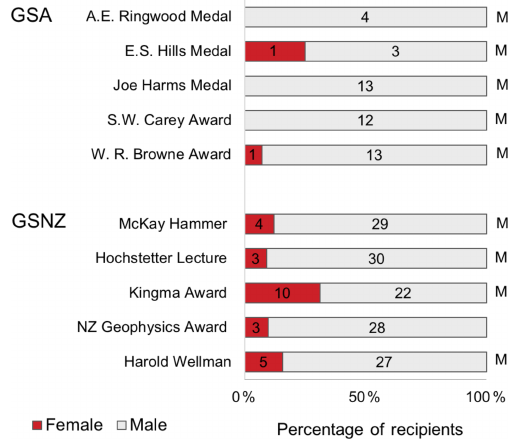
Figure 5. Gender representation in GSA and GSNZ national awards by proportion with the number of recipients indi- cated. The letter on the right-hand side indicates whether the award is named in honour of a male (“M”) or female (“F”). Note that none of these awards were named in honour of a woman. Data taken from the respective society websites